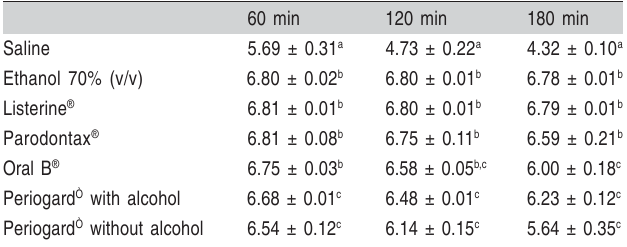
Table 1: Acidogenity of S. mutans biofilms after treatment with different mouthwashes. Values are expressed as mean ± SD of three independent experiments.